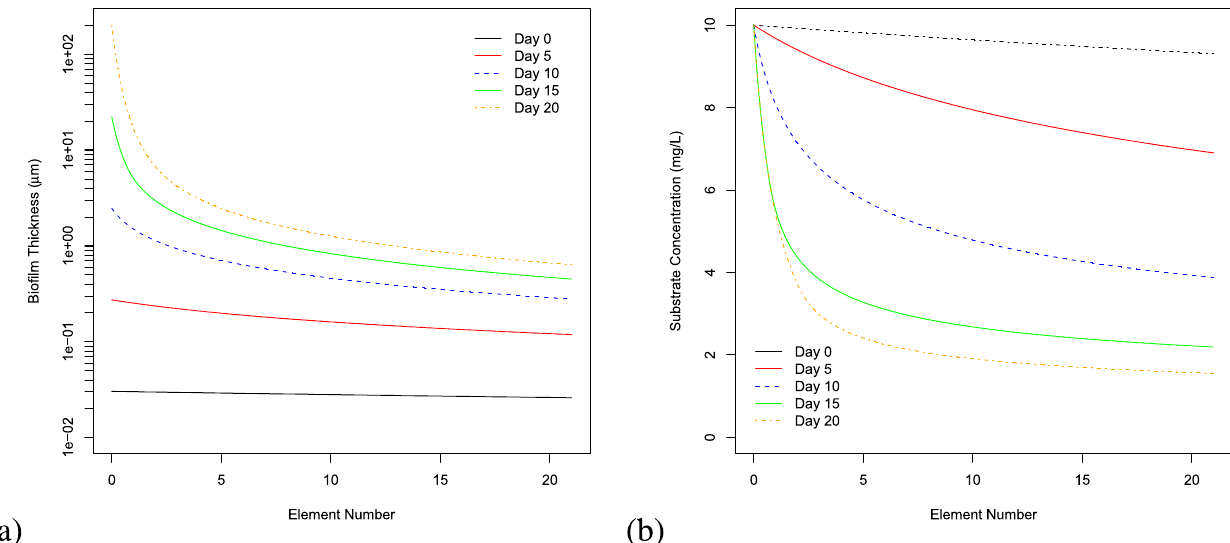
Fig. 8 Model illustration of local substrate limited bio fi lm growth kinetics. Bio fi lm thickness ( a ) and substrate concentration ( b ) pro fi les from inlet to outlet of the RO system showing that with substrate limited growth kinetics the bio fi lm grows thickest at the inlet where the substrate concentration is highest with less growth downstream as substrate concentrations drop due to upstream consumption.